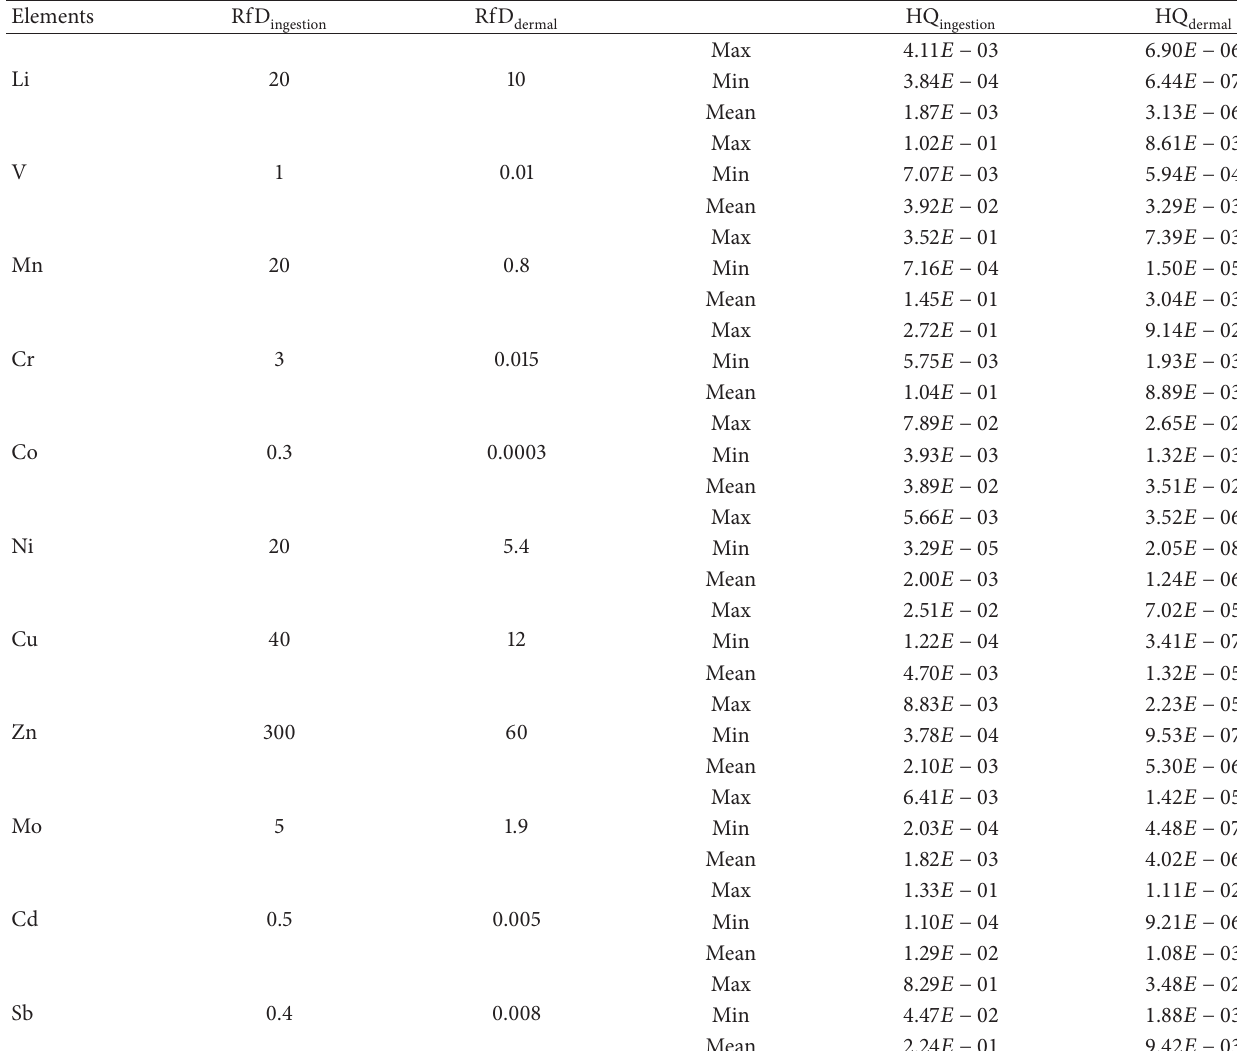
Table 5: Reference dose and hazard quotient for each